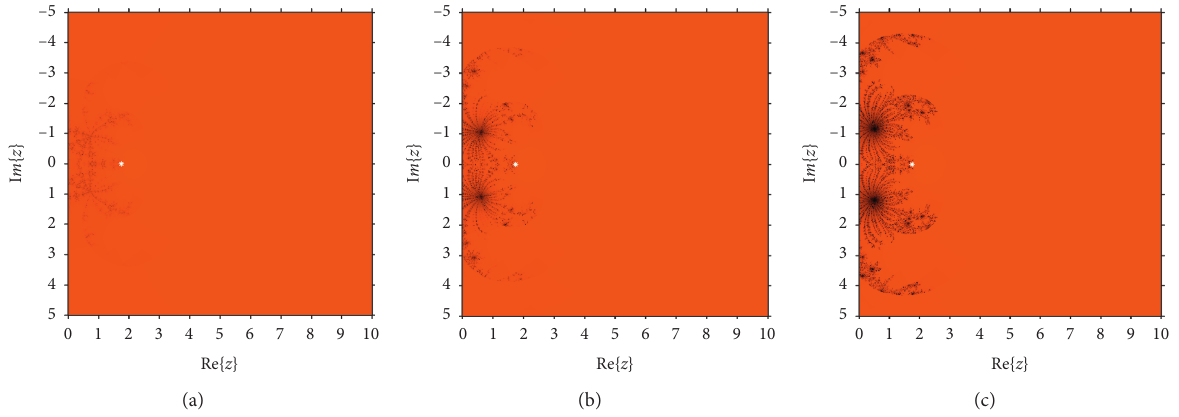
Figure 3: Basins of attraction of (a) BM1, (b) AM2, and (c) ZM3 for g